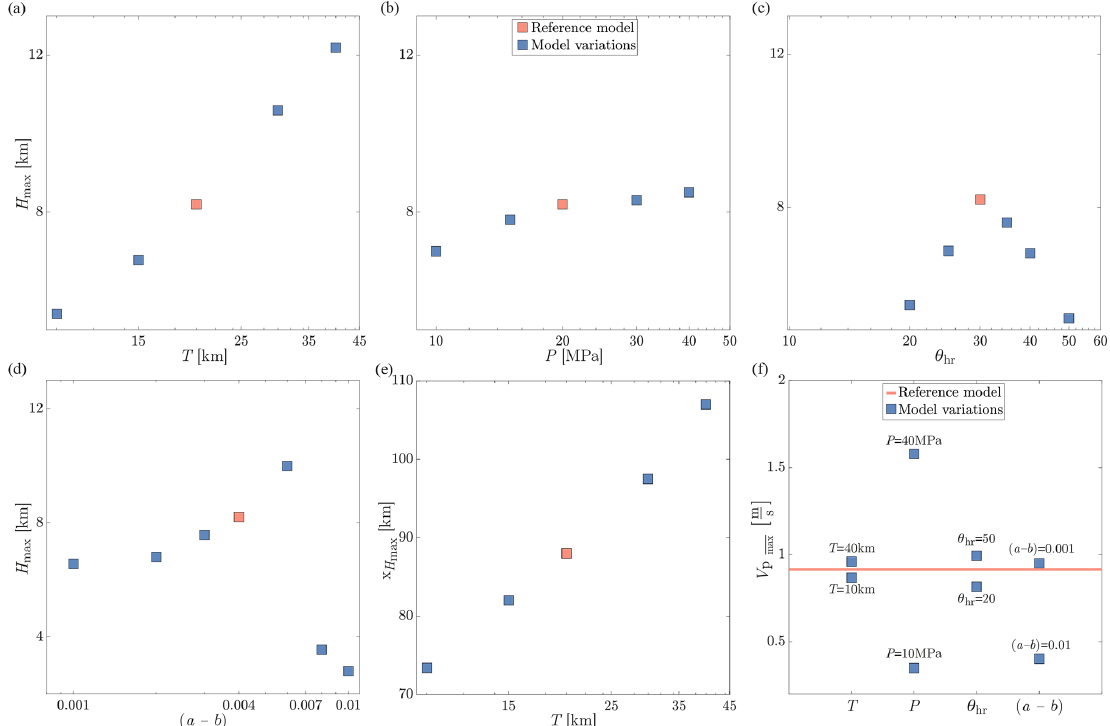
Figure 7. Impact of various parameters on the maximum plastic fan width H max : (a) crustal thickness T ; (b) initial background pressure P ; (c) initial bulk host rock state variable θ hr ; and (d) (a − b) . (e) Relation between the onset of the saturation x H velocity during the first earthquake V p as a function of the highest and lowest parameter of each of the four model variations ( T , P , θ hr , max (a − b)